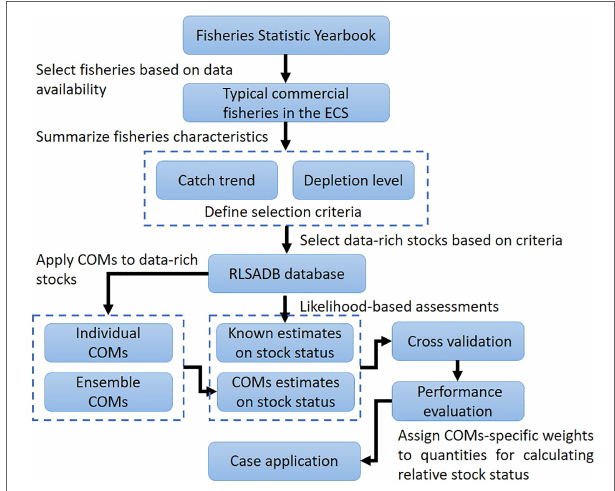
FIGURE 1 | Flowchart for evaluating the performance of COMs based on an empirical